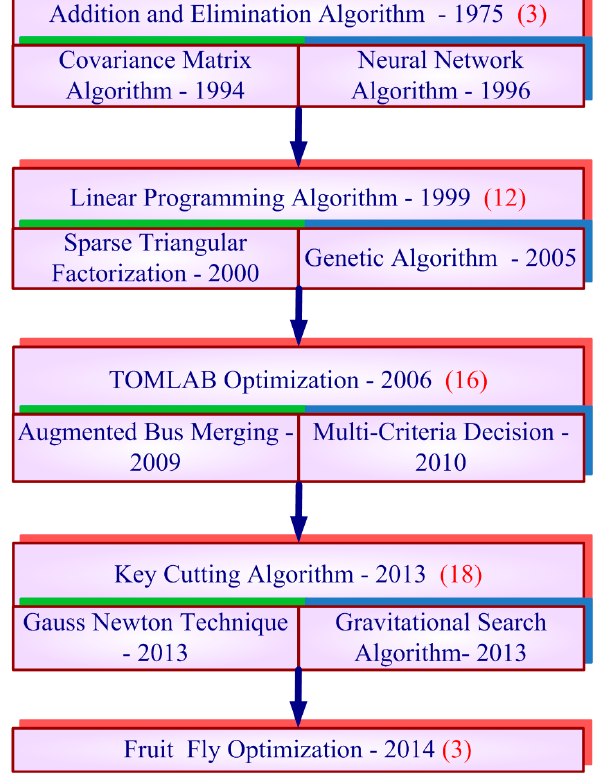
Figure 1. Evolution of online Power System State Estimation (PSSE) Meter Placement Algorithms.